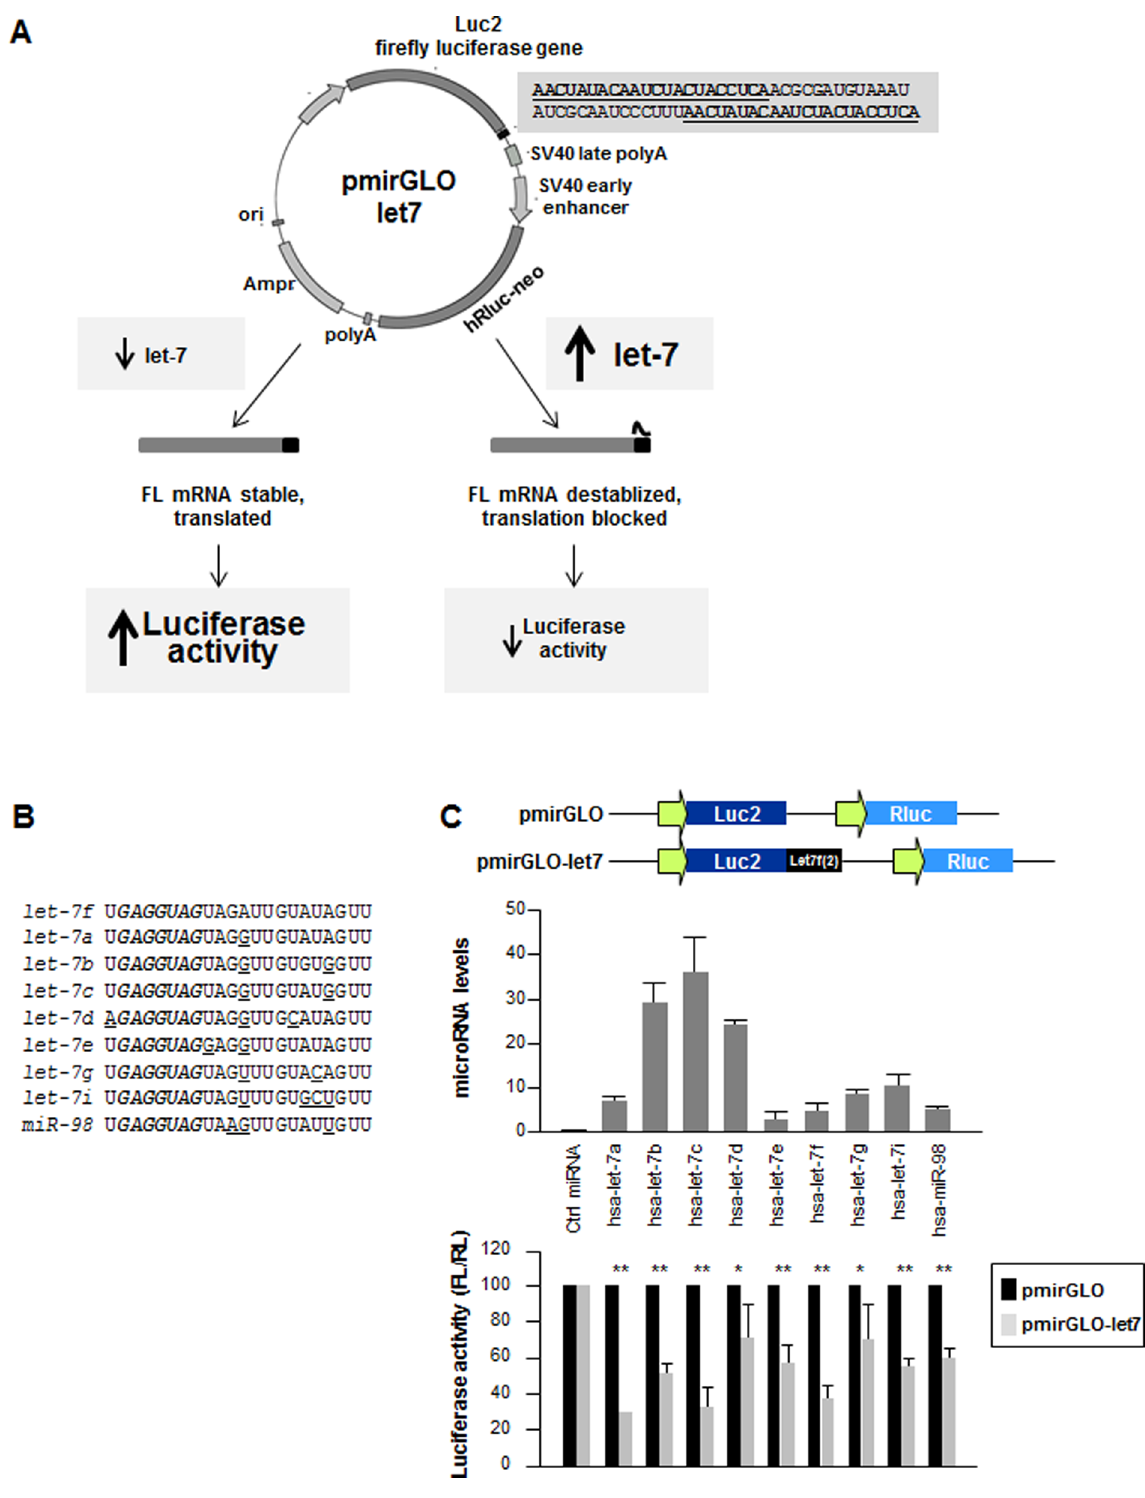
Figure 1. Novel luciferase reporter pmirGLO-let7 to measure let-7 levels in cells. ( A ) Schematic of pmirGLO-let7 vector (adapted from Promega), a dual luciferase vector containing two let-7 target sites (underlined nucleotides, with a 27-nt spacer from lin41, Figure S1). ( B ) Mature sequences of the highly conserved let-7 family; sequence in bold (nucleotides 2–8) are the shared seed region and underlined nucleotides vary between let-7f and other let-7 miRNAs. ( C ) Forty-eight hours after transfecting BG-1 cells with 100 nM let-7 family precursors or with control (Ctrl) miRNA, total RNA was collected and the overexpressed microRNAs were measured by RT-qPCR analysis ( top ). Twenty-four hours after transfection as described in the top panel, BG-1 cells were transfected with pmirGLO-let7; 24 h after that, luciferase activity was measured, normalized to luciferase activity in Ctrl miRNA. Data are the means and standard deviation (S.D.) from three independent experiments: * P , 0.05; ** P , 0.01.